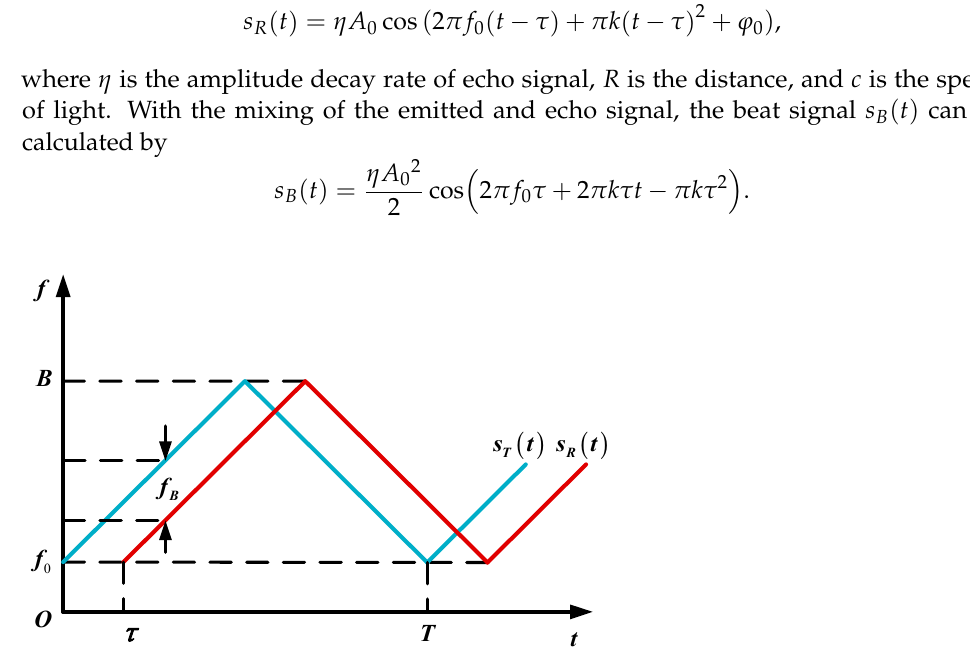
Figure 3. Type of FMCW modulation. The blue and red line represent the emitted signal s T ( t ) and echo signal s R ( t ) ,